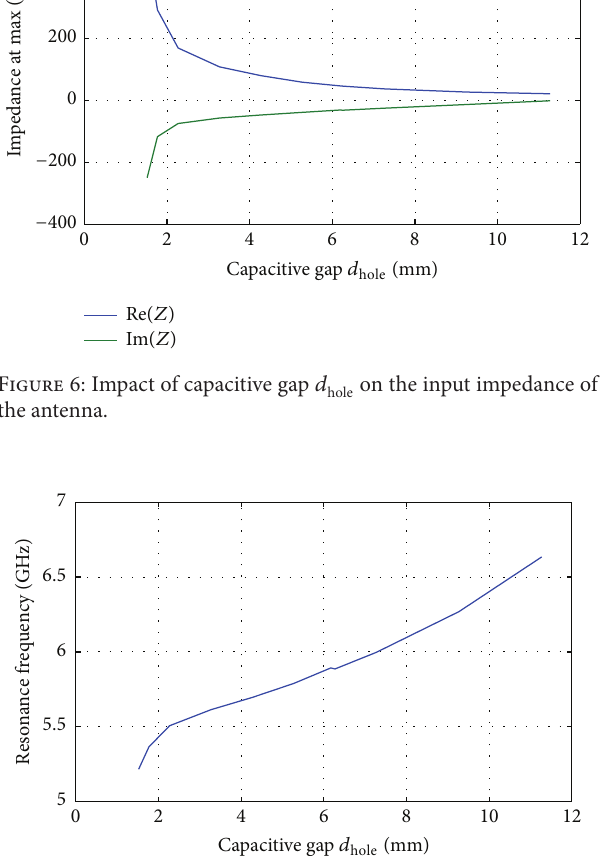
on the resonance frequency hole